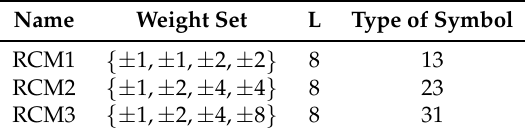
Table 2. Three weight sets of RCM.